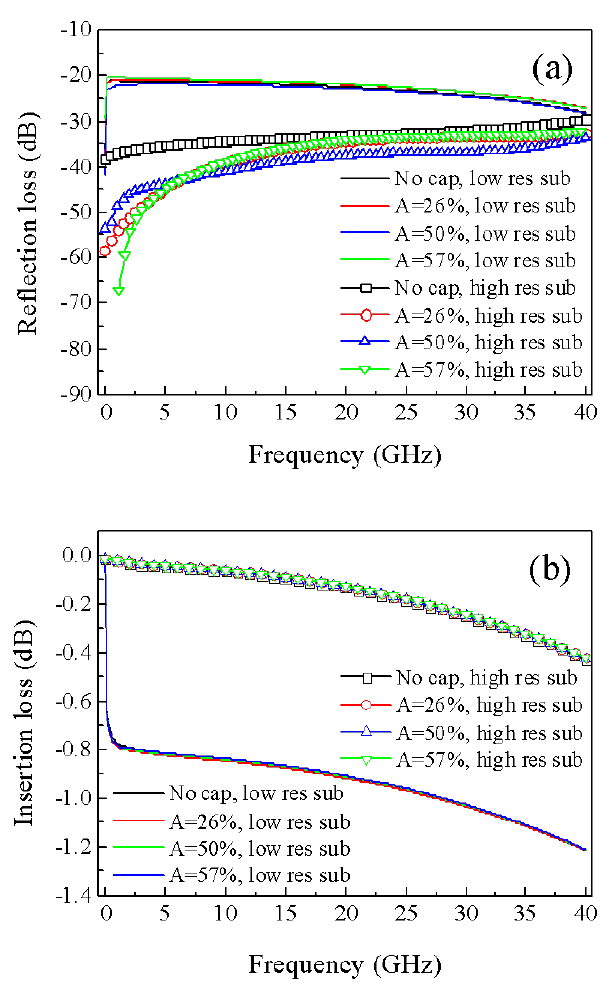
Figure 4 . Magnitude of simulated reflection ( a ) and insertion ( b ) losses for gold coplanar waveguides (CPWs) uncapped and encapsulated with the fabricated caps having A = 26%, 50%, and 57% on low and high resistivity silicon substrates.